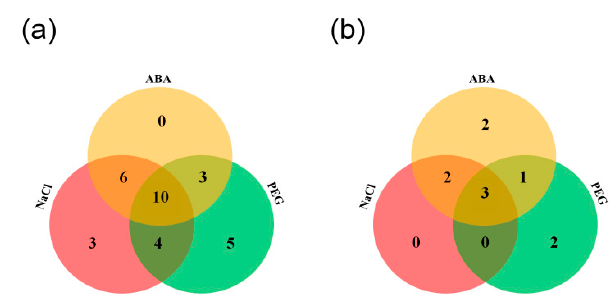
Figure 8. The detailed numbers of simultaneously up-regulated ( a ) and down-regulated ( b ) MtCCT genes by ABA (abscisic acid), NaCl and genes by ABA (abscisic acid), NaCl and PEG.